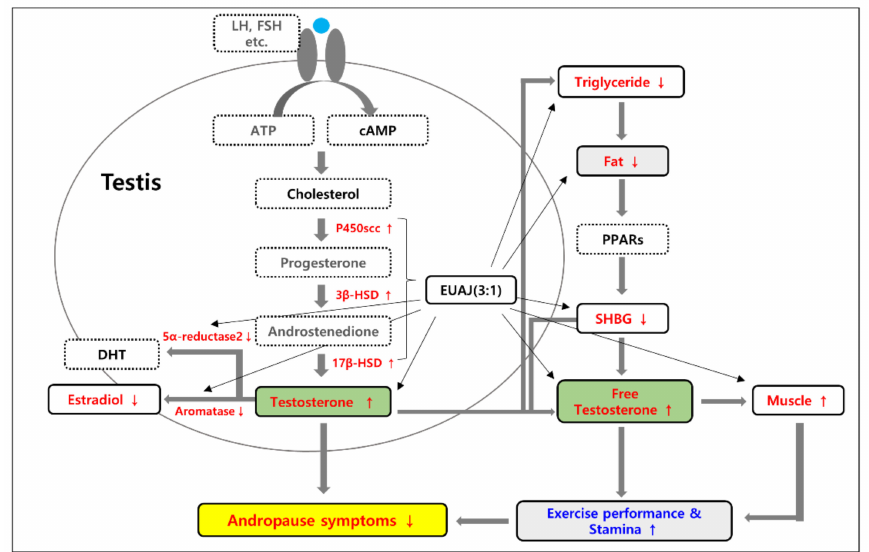
Figure 8. Schematic diagram showing the changes by EUAJ (3:1) treatment on the testicular steroido- genesis pathway and exercise performance in improving andropause